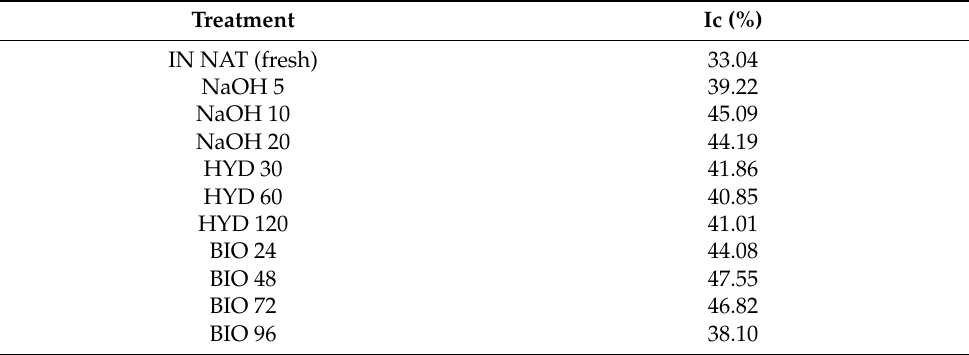
Figure 4. XRD for samples after chemical treatments, ( a ) in natura CHFW; ( b ) NaOH; ( c ) HYDRO; and ( d ) BIO treatment. Table 3. Crystallinity index of in natura CHFW and after